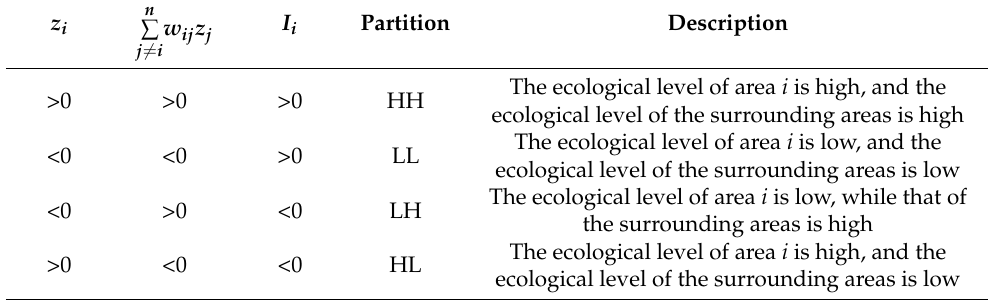
Table 4. Results of local Moran’s I